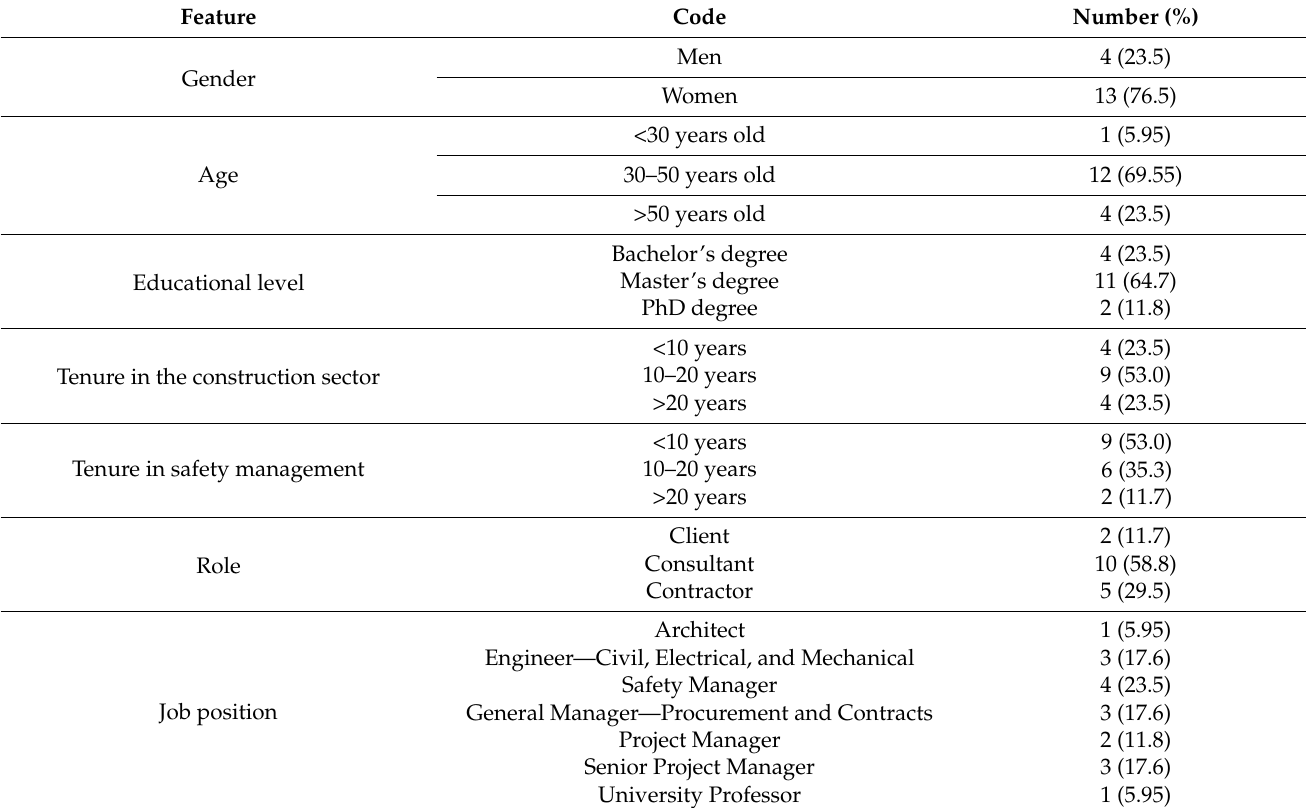
Table 1. Demographic information of the Delphi study’s